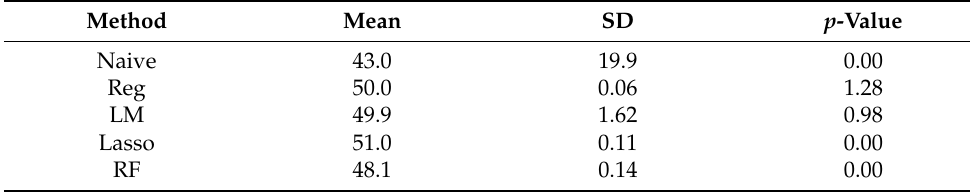
Table 2. Summary results for ATE true = 50, linear.